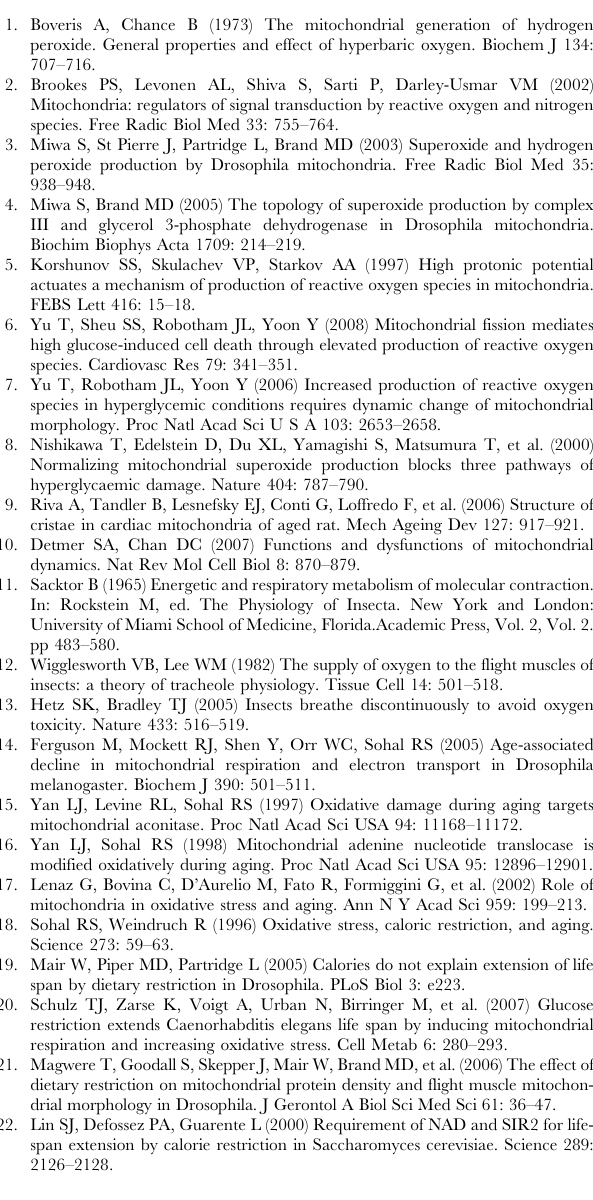
Figure S3 Blood meal induces a time-dependent reversible inhibition of mitochondrial oxygen consumption. Representative traces of oxygen consumption in sugar fed (SF, solid black line) and five different times ABM (0.25 h, 2 h, 24 h, 40 h and 72 h - solid grey, dashed and dotted lines) A. aegypti FM mitochondria using 10 mM of the substrates pyruvate-proline (PP). The phosphory- lating state 3 respiration was induced by the addition of 1 mM ADP (ADP), and the non-phosphorylating state 4-like respiration was induced by the addition of 4 m g/mL oligomycin (O). Uncoupled respiration was measured by using 5 m M FCCP (F). Figure S4 Blood-feeding reduces mitochondrial H 2 O 2 genera- tion induced by G3P. Representative H 2 O 2 formation traces of sugar fed (SF, gray line) and 24 h ABM (BF, black line) A. aegypti FM mitochondria using 10 mM of glycerol 3-phosphate + 1 mM ADP (G3P +